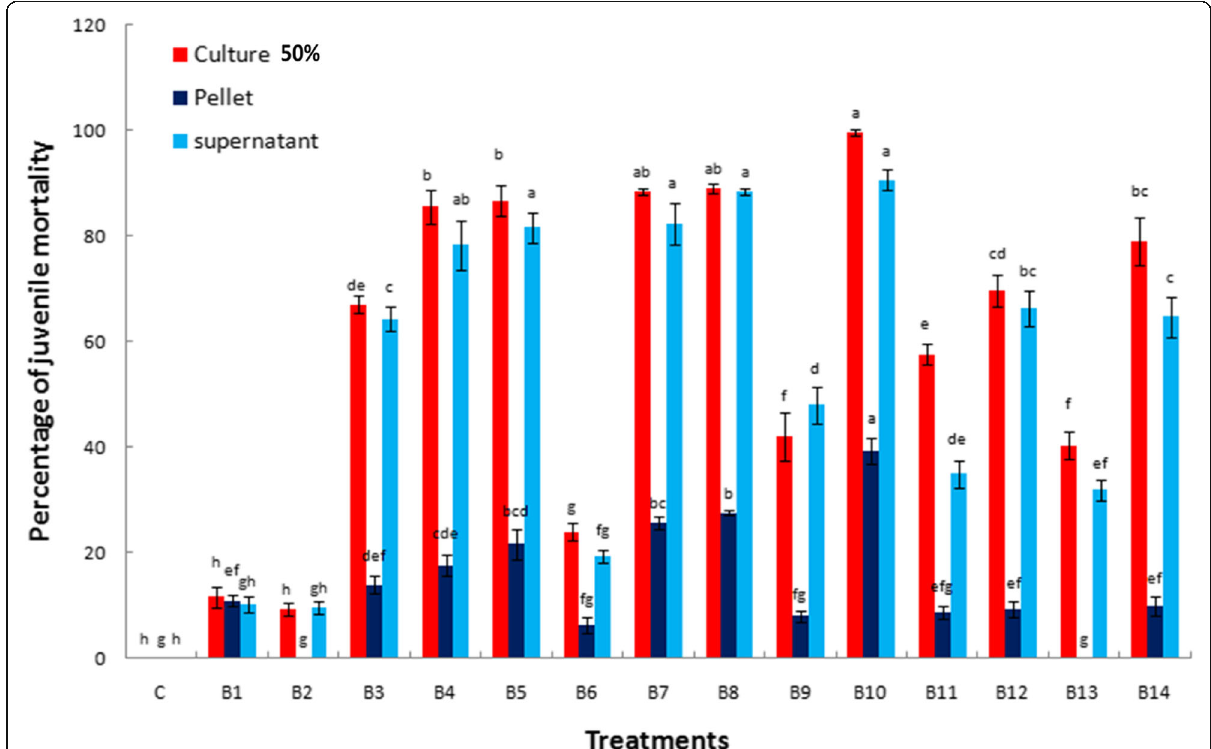
Fig. 3 Effect of culture broth, cell pellet, and supernatant of 14 Bacillus subtilis isolates (B1 to B14, C is a control) on juvenile mortality of Meloidogyne incognita at a concentration of 50%. Values with the identical letters above the bar are not significantly different at P < 0.05